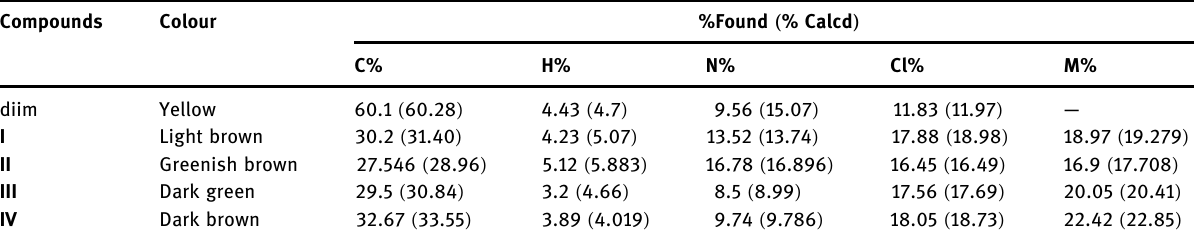
Table 1: Physicochemical studies for methoxy - diim free ligand and its metal complexes Compounds